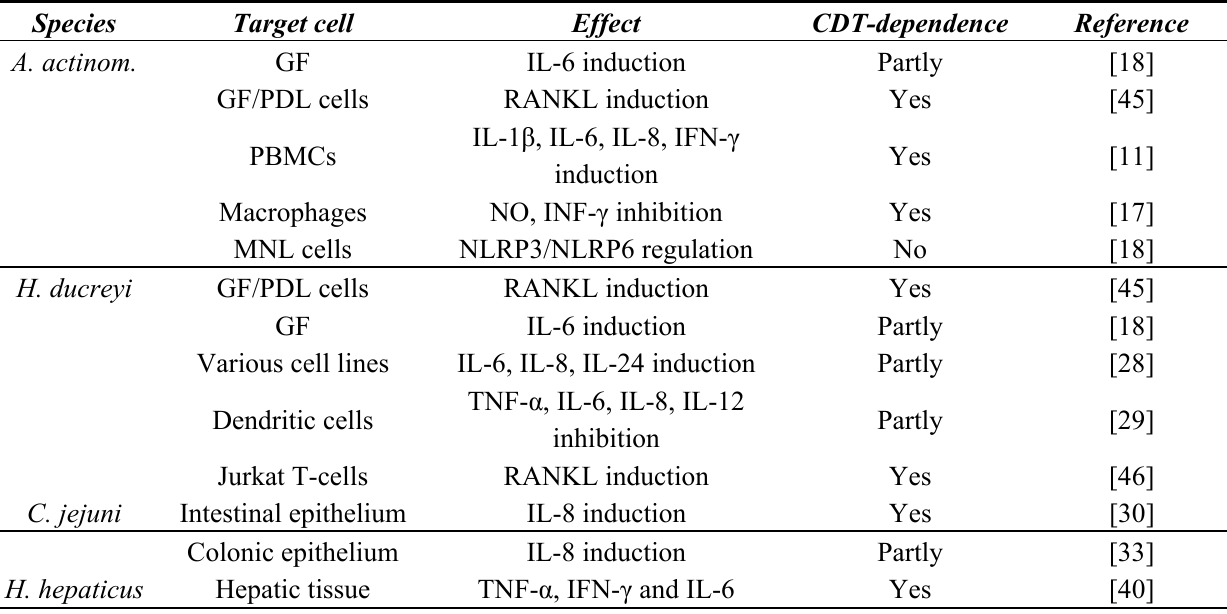
Table 1. Summary of the literature: effects on cytolethal distending toxins (CDTs) on the production of host inflammatory mediators by various cell